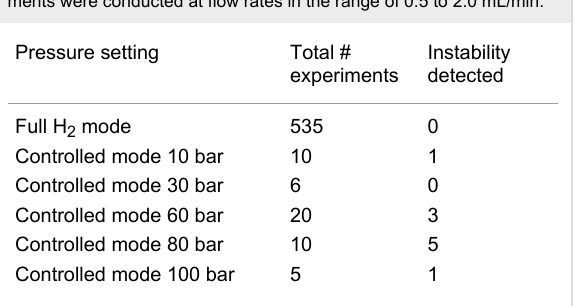
Table 1: The number of experiments during which an “instability” was detected and automatically recorded by the AutoH 3 system. Experi- ments were conducted at flow rates in the range of 0.5 to 2.0 mL/min.